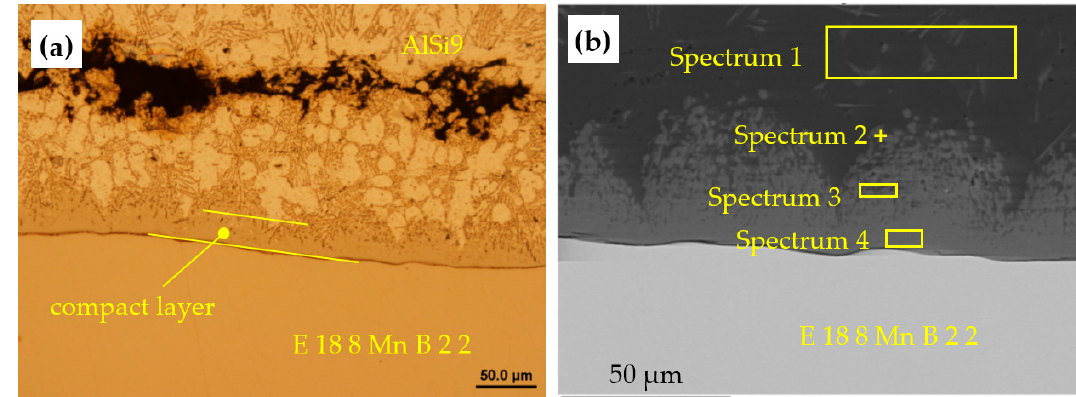
Figure 18. E 18 8 Mn B 2 2/680 ± 20 °C/300 min/AlSi9. Intermetallic compounds at the boundary between the E 18 8 Mn B 2 2 deposit and the solidified aluminum alloy melt ( a ). EDX semi-quantitative microanalyses ( b ).